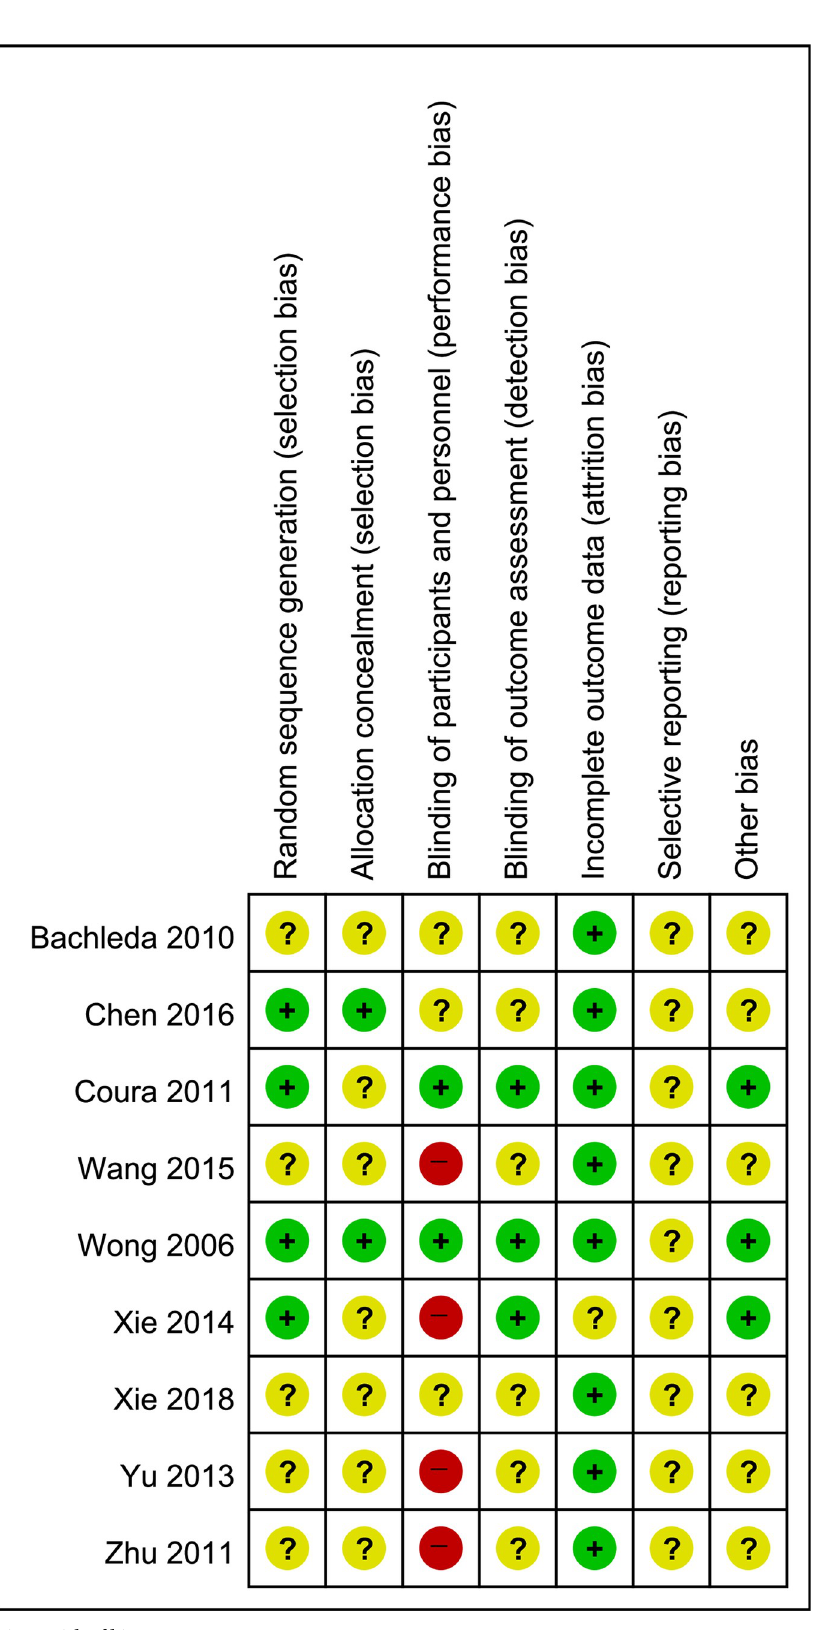
Fig 2. Risk of bias